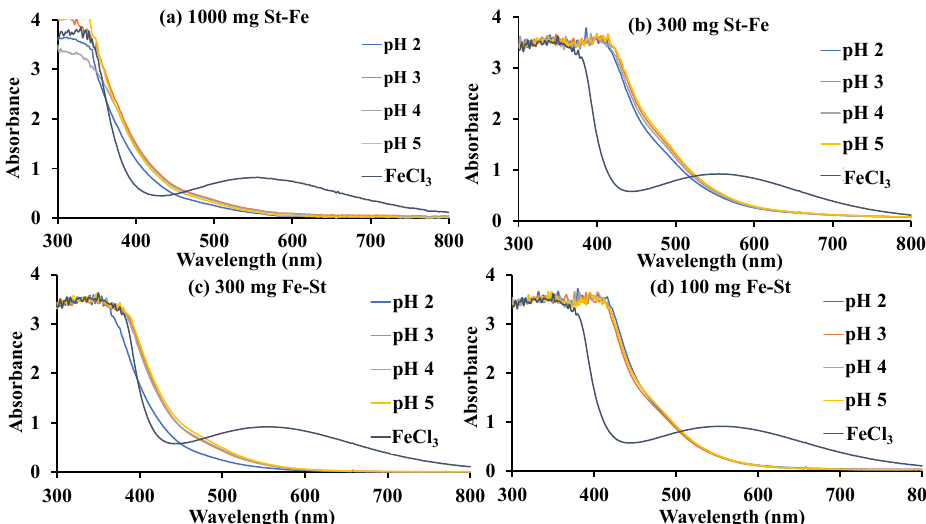
Figure 7. UV–vis absorbance spectra for 0.01 M Fe aliquots of the different catalysts treated with 0.06 M phenol at pH 2, 3, 4, and 5; 0.02 M ferric chloride was used as a control.